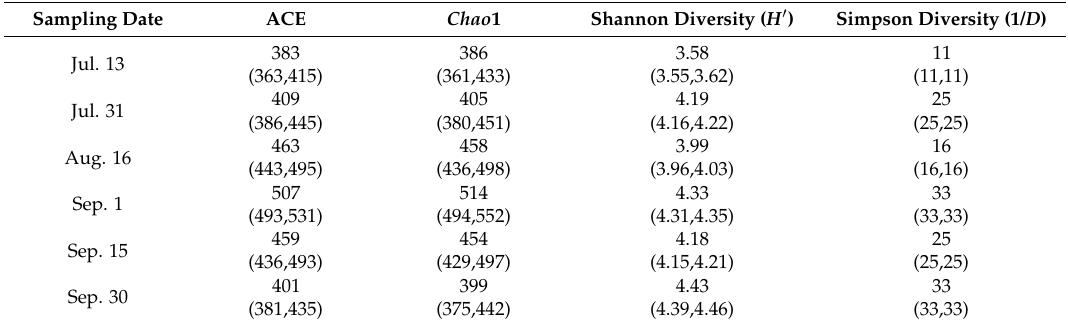
Table 3. Water bacterial community diversity indices measured based on the Illumina MiSeq sequencing data of Zhoucun drinking water reservoir during algal bloom outbreak and decline from July to September, 2012.